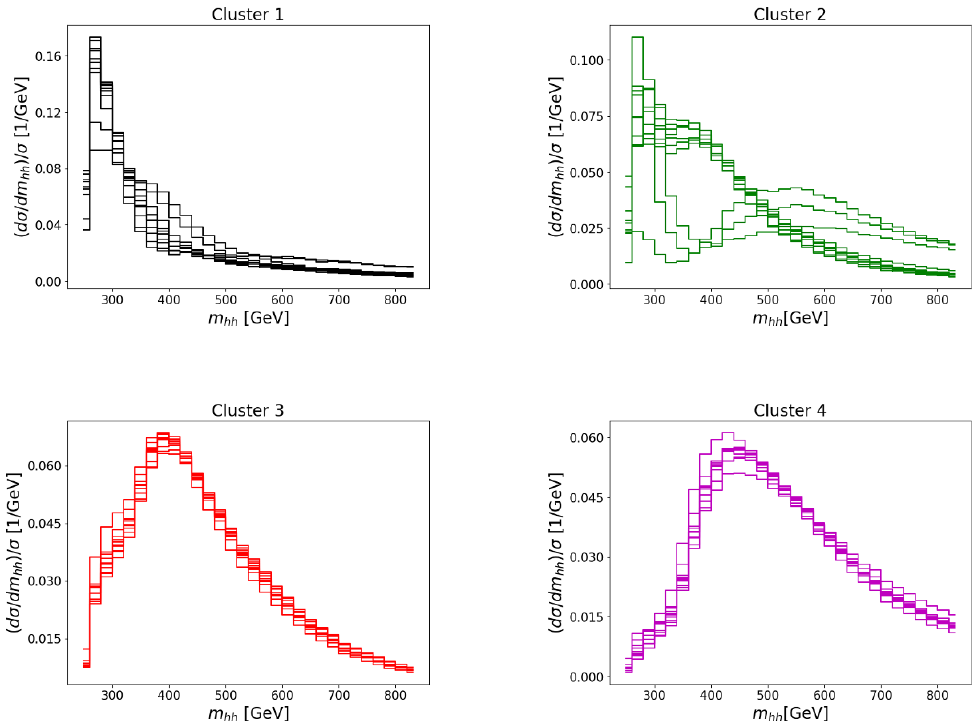
Figure 9 . The clusters obtained by asking for a classi(cid:12)cation into four shape types. We show the cluster centres obtained from 10 di(cid:11)erent encoder models, in the colour code de(cid:12)ned in table